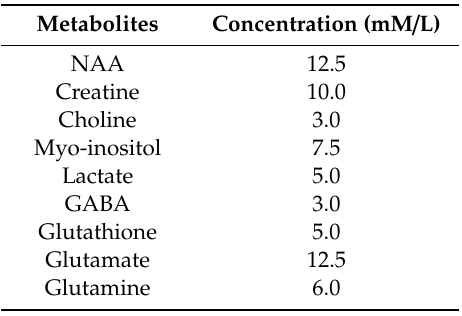
Table 2. Phantom data metabolites